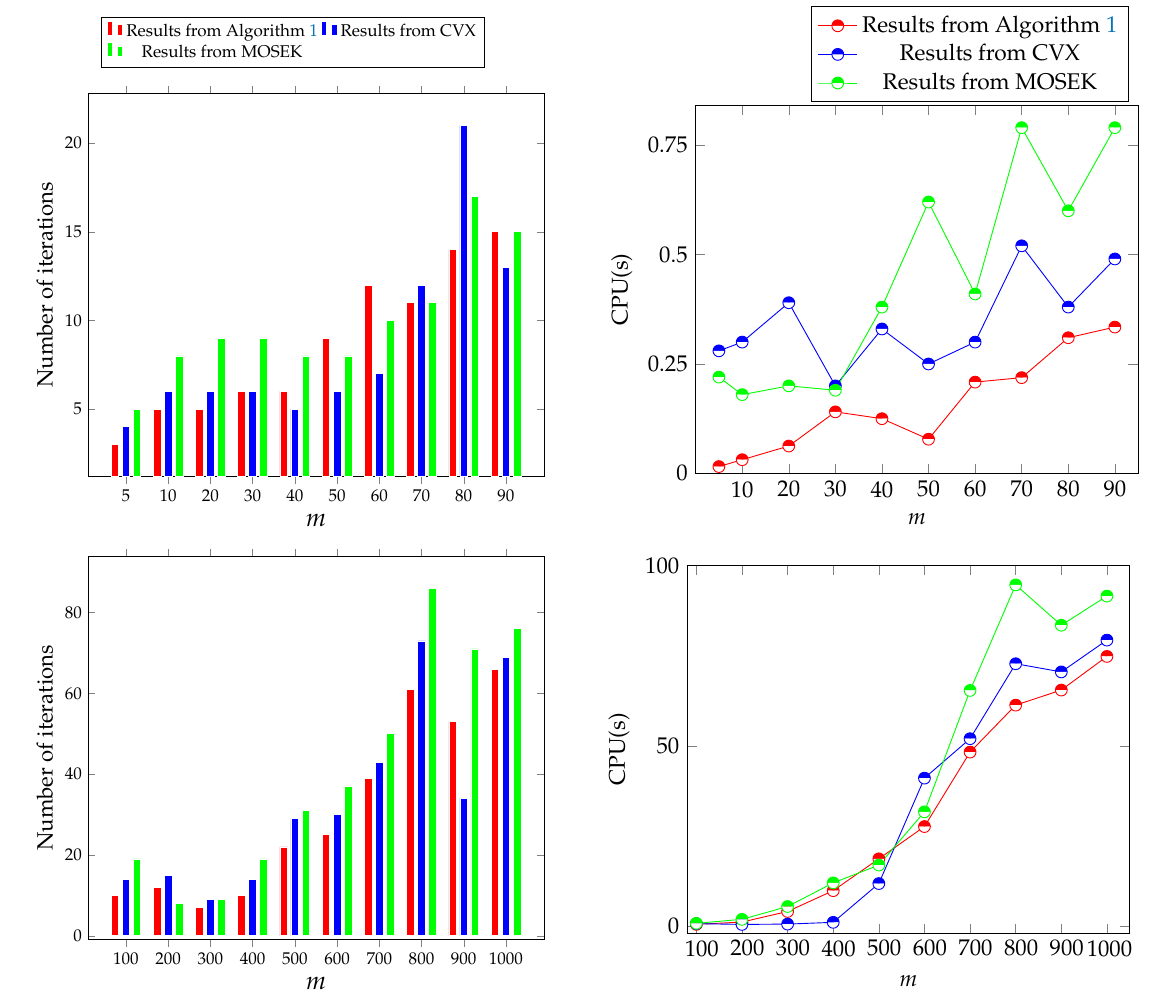
Figure 4. Two-dimensional plots for the numerical results in Example Figure 6.2. Two-dimensional plots for the numerical results in Example 6.2.